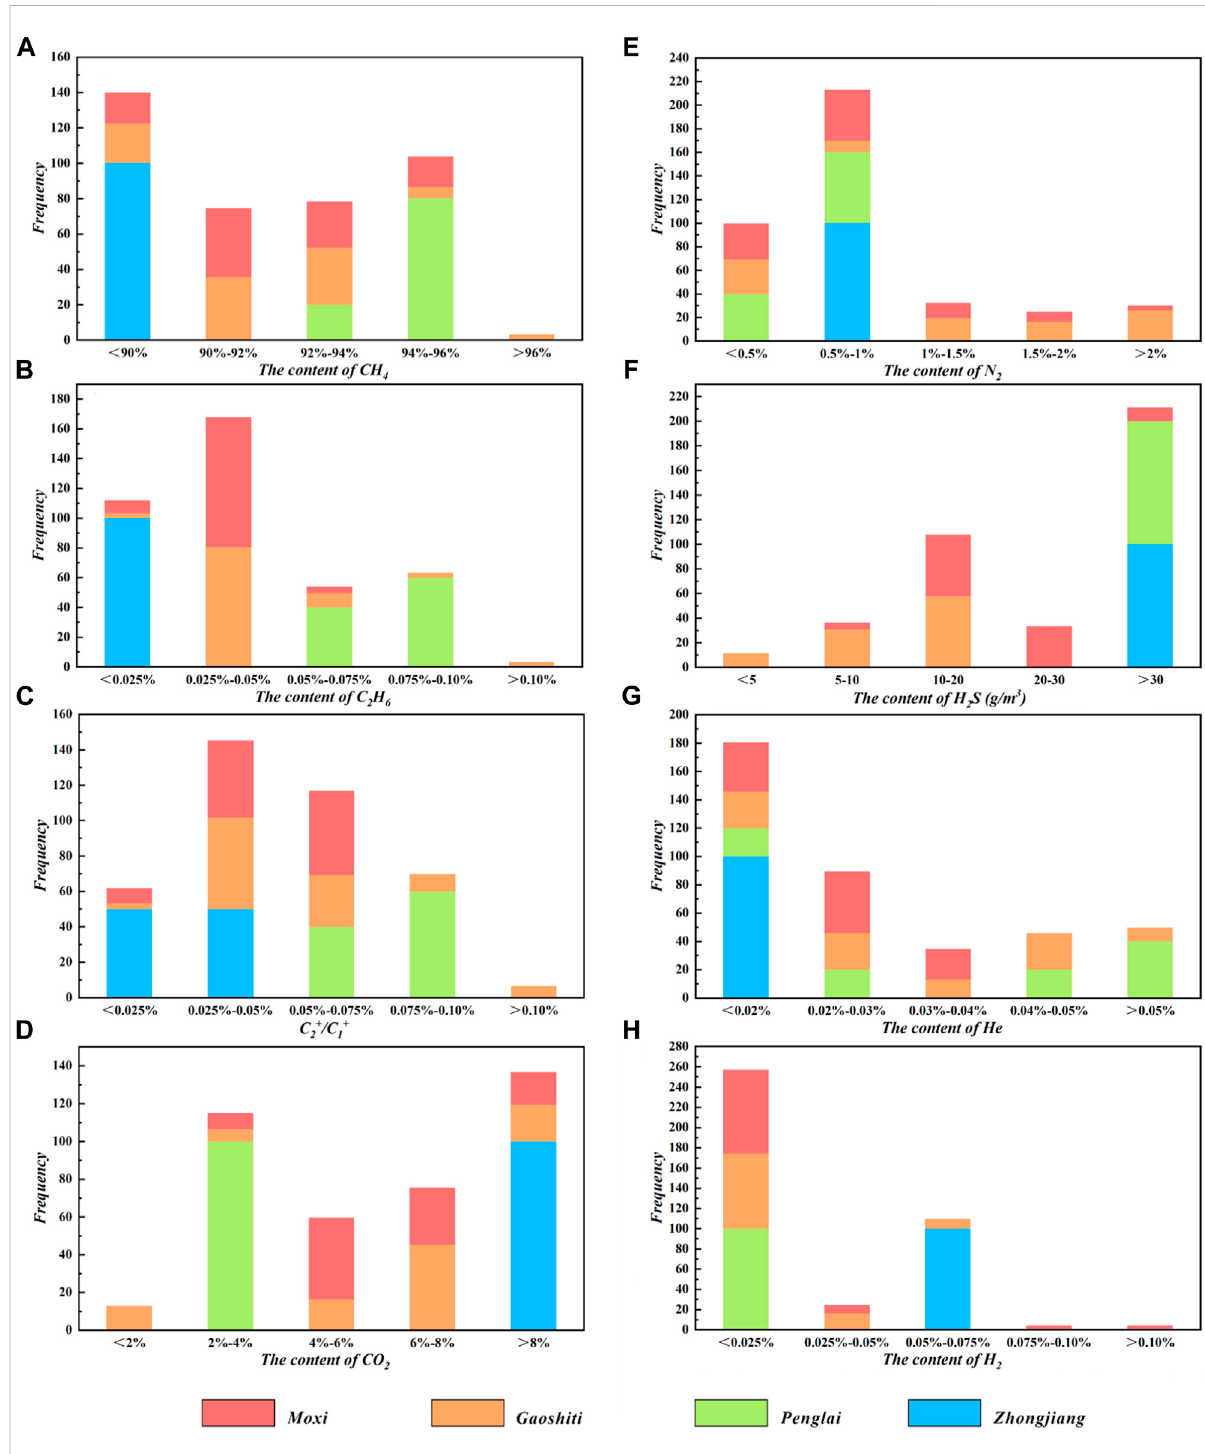
FIGURE 2 Histograms show the comparison of natural gas composition from the Gaoshiti-Moxi area (the Moxi and Gaoshiti areas) and the North Slope (the Penglai and Zhongjiang Blocks). The frequency histograms showing the distribution of the CH 4 content (A) , C 2 H 6 content (B) , C 2+ /C 1+ (C) , CO